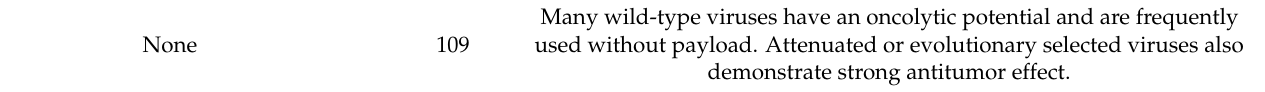
Table 2. Oncolytic viruses engineering and payloads in clinical practice.